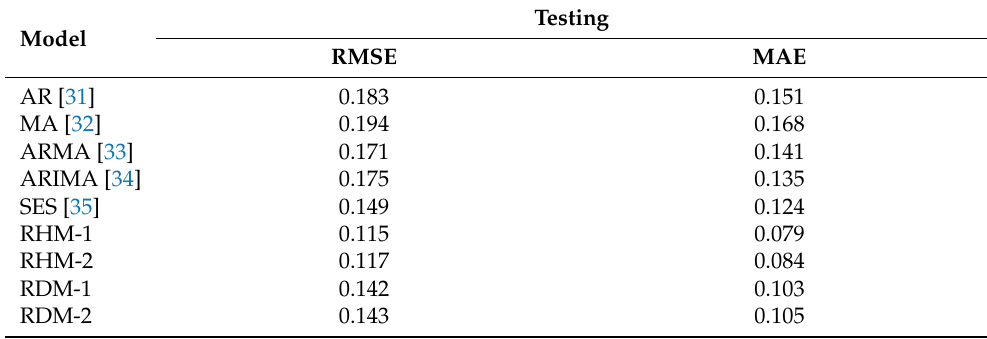
Table 22. Validation of models in testing environment by comparing with classical